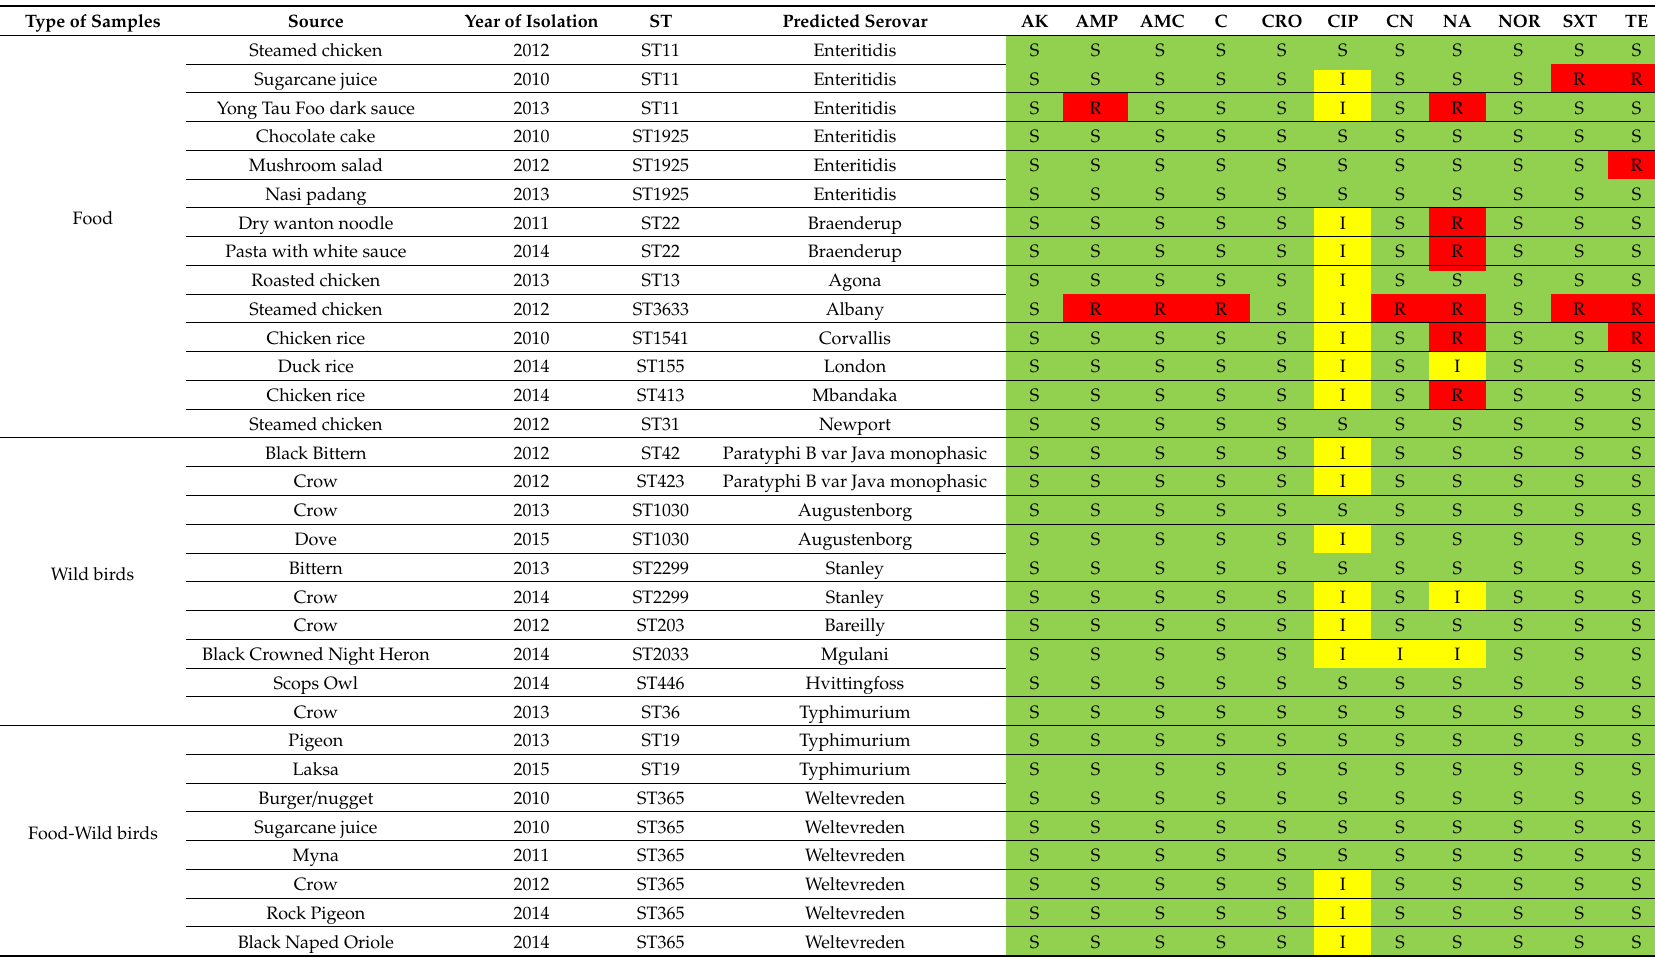
Table 4. Characteristics of Salmonella isolates from food and wild birds (ST: Sequence type, MLST: Multi locus sequence typing, AK, Amikacin; AMP, Ampicillin; AMC, Amoxycillin-Clavulanic acid; C, Chloramphenicol; CRO, Ceftriaxone; CIP, Ciprofloxacin; CN, Gentamicin; NA, Nalidixic acid; NOR, Norfloxacin; SXT, Trimethoprim-Sulphamethoxazole; TE, Tetracycline). S, Sensitive (Green); I, Intermediate (Yellow); R, Resistant (Red). Type of